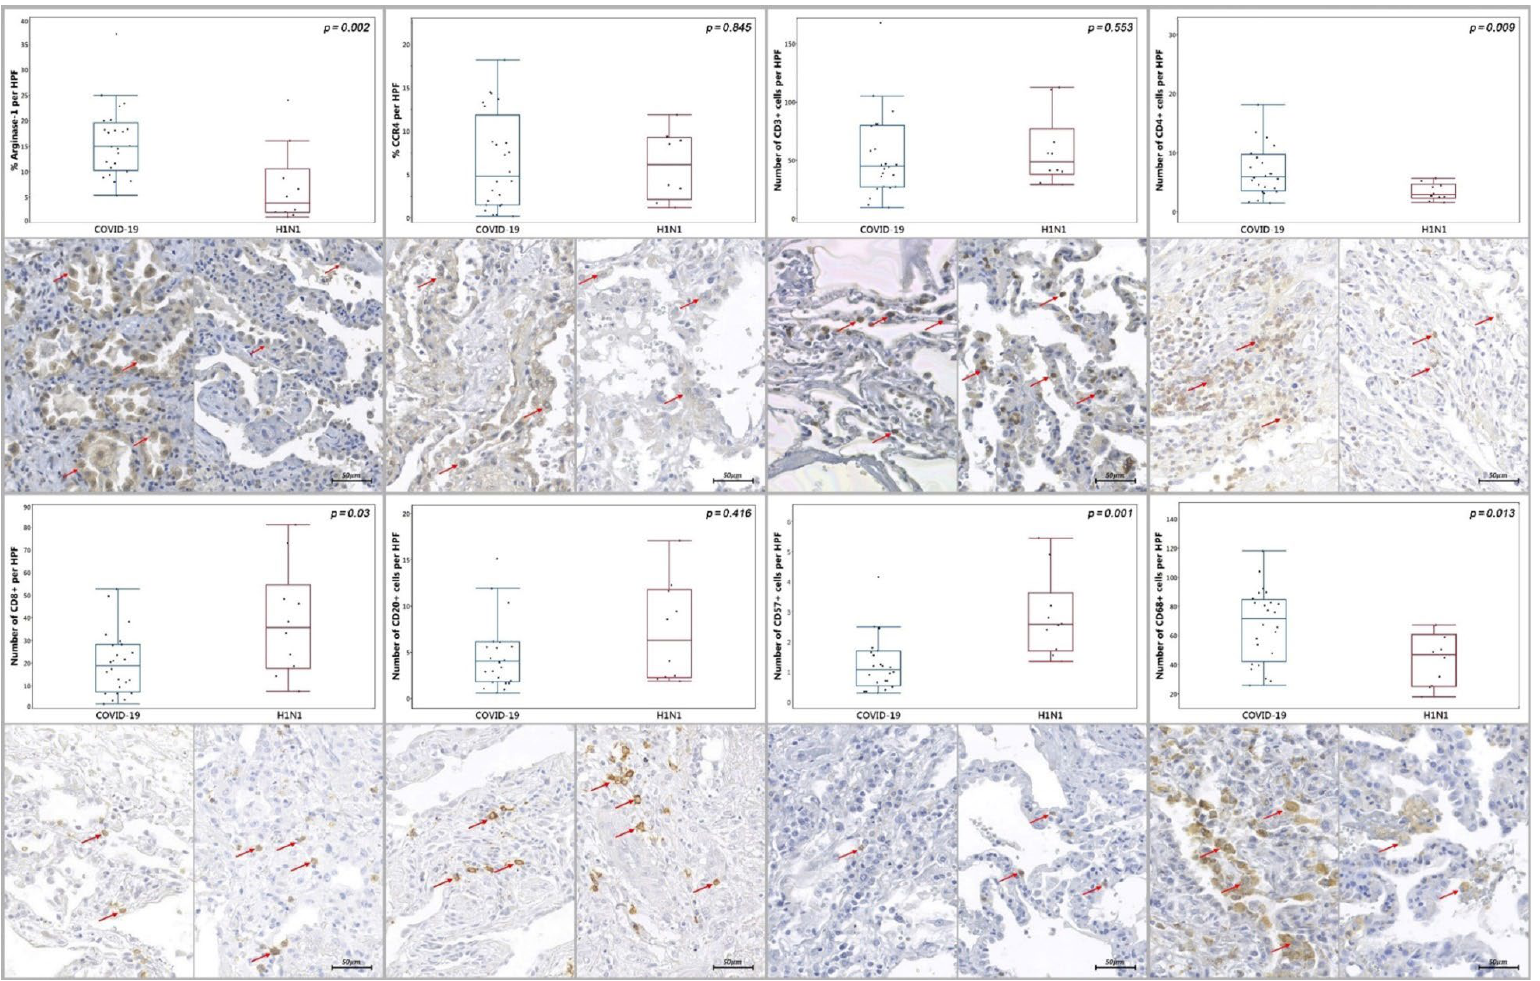
Figure 1. Graphs demonstrating tissue immunoexpression of Arginase-1 (percentage per HPF) and the number of immunopositive cells per HPF of CCR4, CD3+, CD4+, CD8+, CD20+, CD57+ and CD68+ in the alveolar epithelium in the COVID-19 and H1N1 groups. Red arrows denote the immunoexpression of each tested marker.